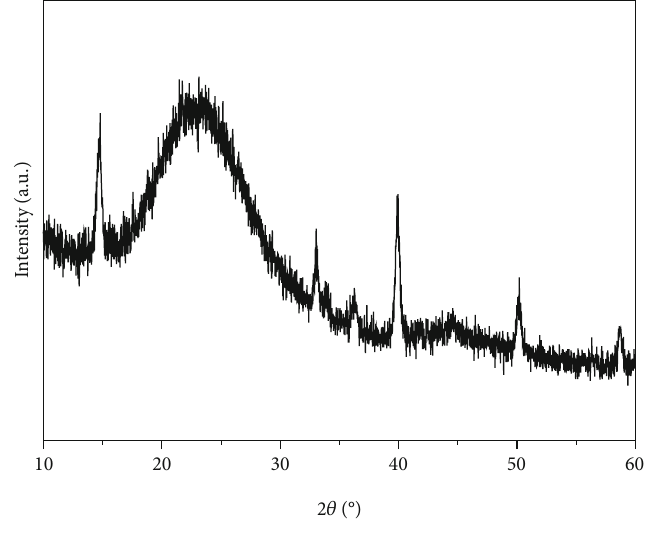
Figure 3: XRD spectrum of MYNS.